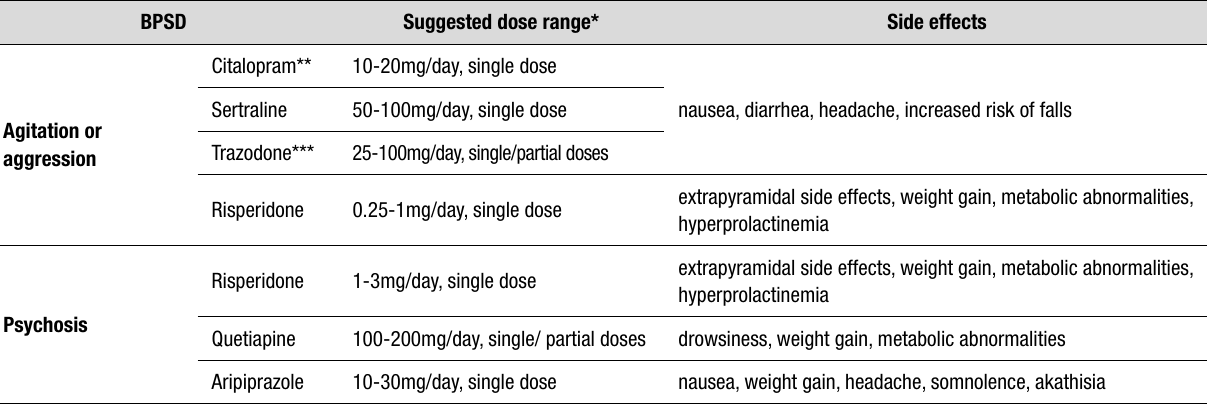
Table 2. Consensus-based recommendation for the use of psychotropic medication in specific behavior and psychological symptoms of dementia (BPSD) associated with severe Alzheimer’s dementia.